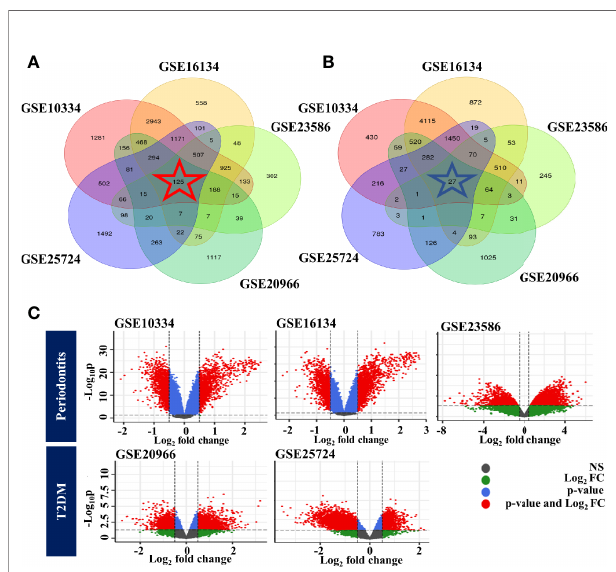
FIGURE 2 | Identi fi cation of common DEGs for each disease. (A) Venn diagram of upregulated genes. (B) Venn diagram of downregulated genes. (C) Volcano plot of DEGs identi fi ed in individual cohorts. The color of the points in the volcano plot indicates gray: not signi fi cant, green: passed only the log2 fold change, blue: passed only the p-value, red: passed the p-value and log2 fold change. PD, Below: